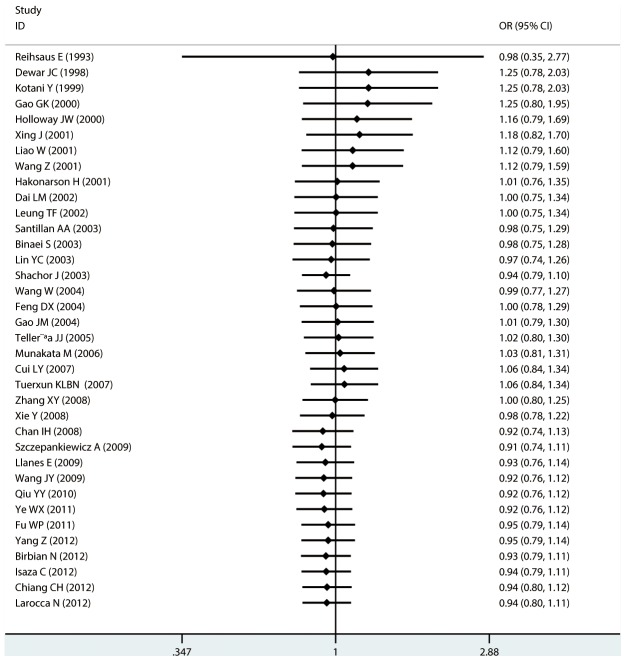
Forest plots of cumulative meta-analysis of Gln27Glu (rs1042714) in association with asthma by published year under homozygote genotype comparison.